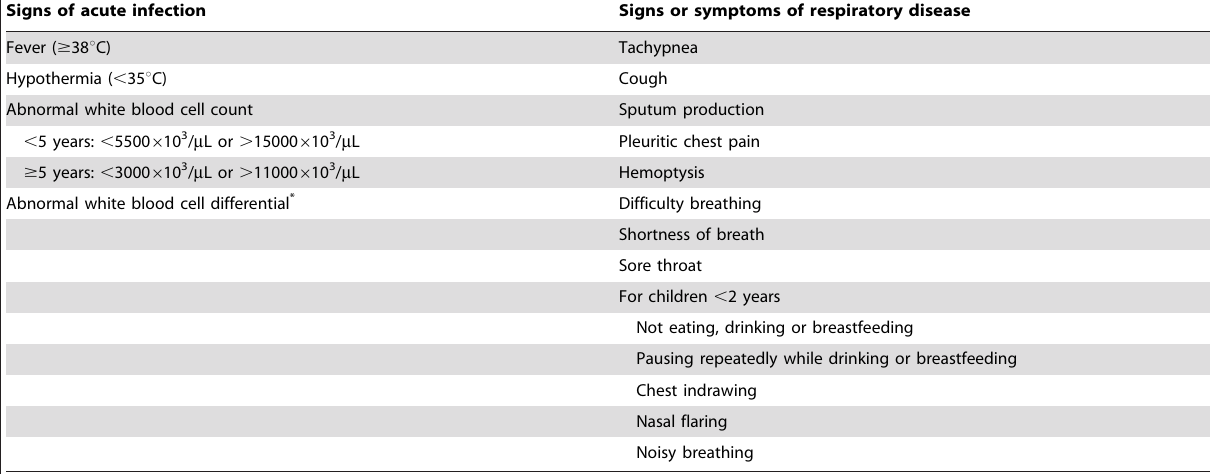
*Any white blood cell differential abnormality as defined by the automated blood cell analyzer at each surveillance site. For Santa Rosa: lymphocytes , 25% or . 45%, monocytes , 2% or . 10%, granulocytes , 50% or . 70%. For Quetzaltenango: lymphocytes , 20% or . 50%, monocytes , 4% or . 8%, neutrophils , 40% or . 70%, eosinophils . 6%, basophils . 2%.